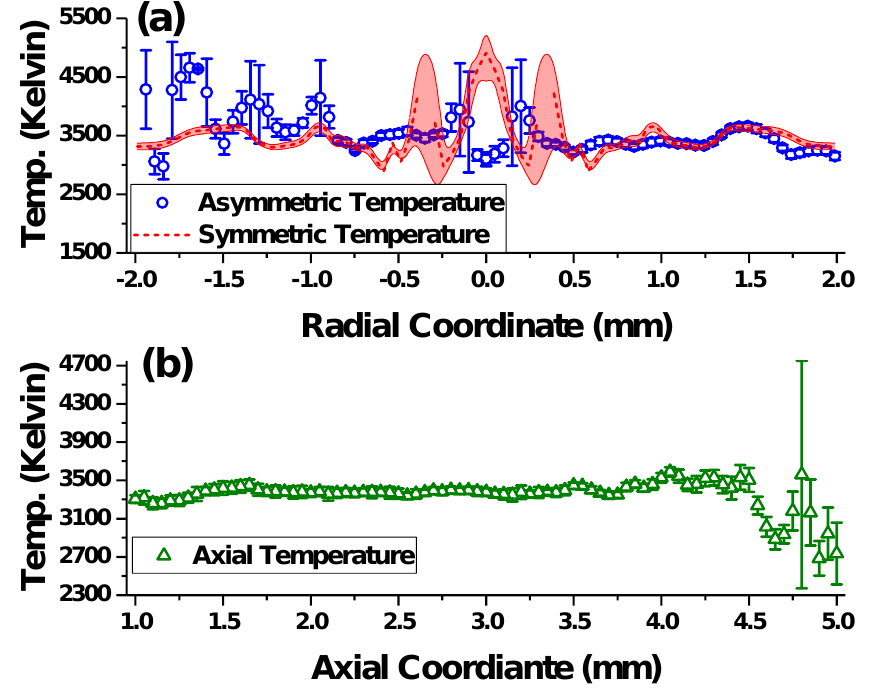
Figure 3. Temperatures inferred from AlO spectra at a time delay of 20 µ s following ablation ( a ) along the plasma radius using asymmetric and symmetric Abel inverted spectra and ( b ) along the plasma using spatially resolved line-of-sight spectral measurements.